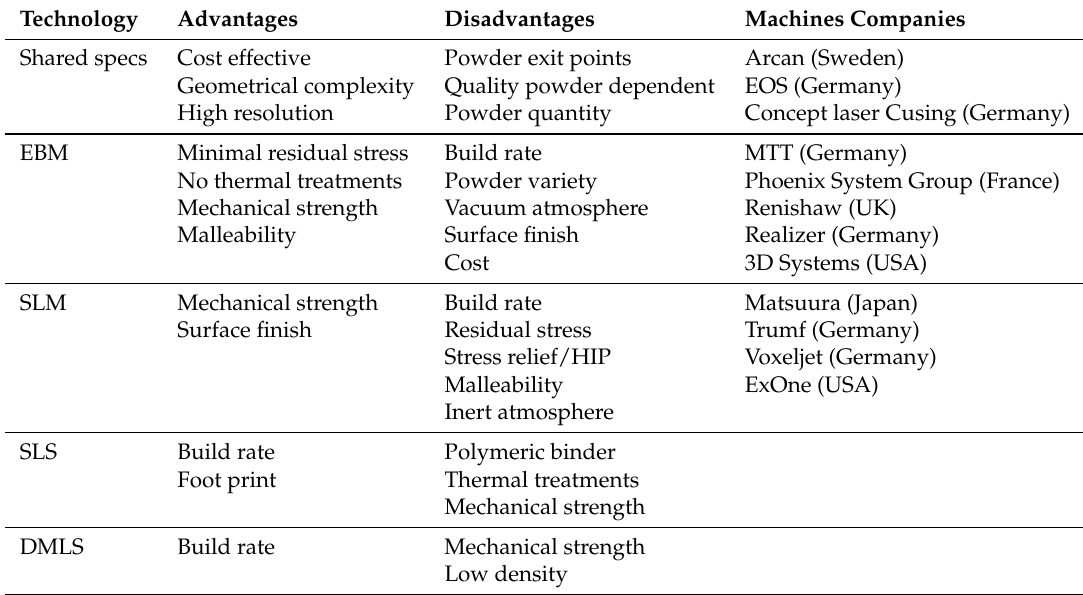
Table 2. PBF process